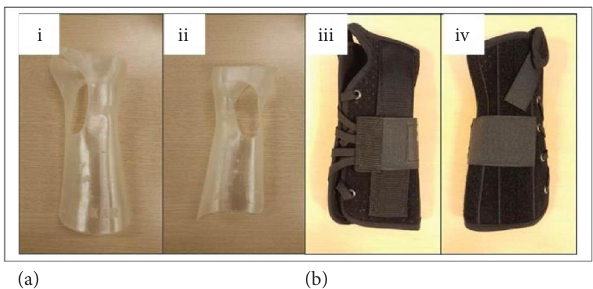
Figure 5: Te wrist orthosis was printed out using fused flament fabrication (FFF) type 3D printer. (a) Termoplastic polyurethane (TPU) flament was used as the output material, and the inner surface directly touching the skin was smoothed through postprinting process. (b) A readymade wrist orthosis was used for the control